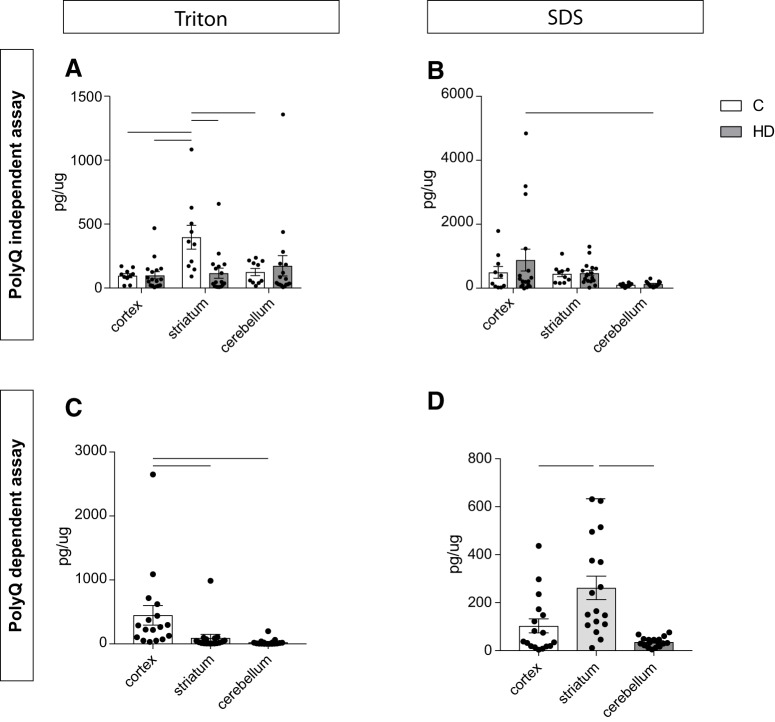
HTT detection in human postmortem tissue. Human postmortem tissue from cerebral cortex, striatum, and cerebellum was processed using the polyQ-independent (A, B) and -dependent (C, D) assays in cytoplasmic (Triton; A, C) and nuclear (SDS; B, D) fractions. In A and B, statistical analysis has been performed using two-way ANOVA with Tukey’s multiple comparisons test (in A: cortex C versus striatum C, p = 0.0211, cortex HD versus striatum C, p = 0.007, striatum C versus striatum HD, p = 0.0129, striatum C versus cerebellum C, p = 0.0479; in B: cortex HD versus cerebellum HD, p = 0.0329). In C and D, statistical analysis has been performed using Kruskal–Wallis with Dunn’s post hoc test after verifying normal distribution using Kolmogorov–Smirnov test (in C: cortex versus striatum, p = 0.0025, cortex versus cerebellum, p < 0.0001; in D: cortex versus striatum, p = 0.0141, striatum versus cerebellum, p < 0.0001). The data are presented as mean ± SEM.